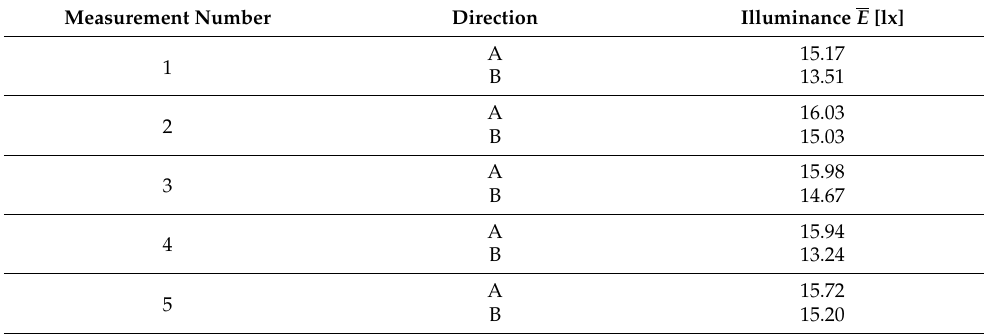
Table A10. Example of the results for measurement field No.